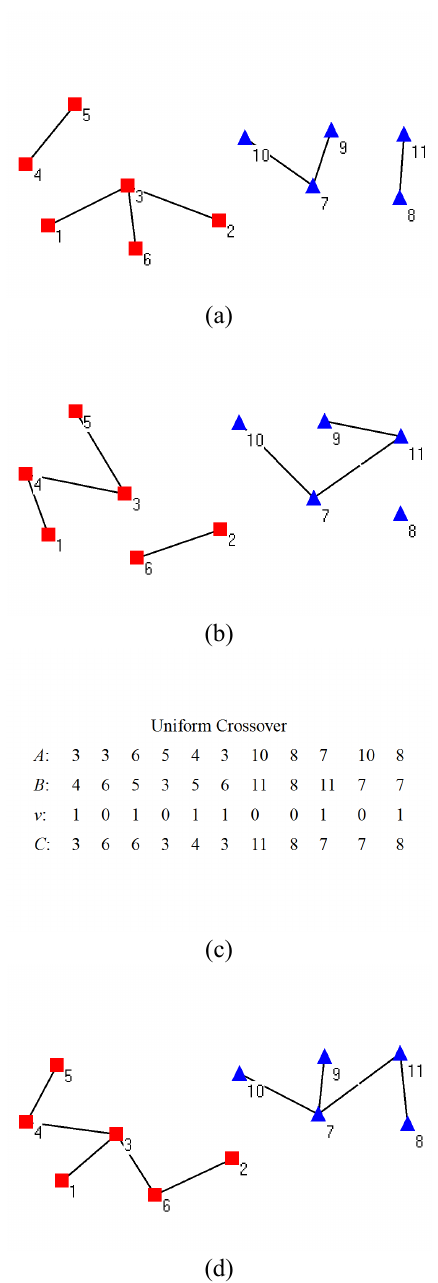
Fig. 2. (Color online) An illustration of the uniform crossover on the network in Fig. 1(a). (a) The corresponding graph of parent A ; (b) The corresponding graph of parent B ; (c) Uniform crossover of parents A and B yielding child C by using random binary vector v ; (d) The corresponding graph of child C